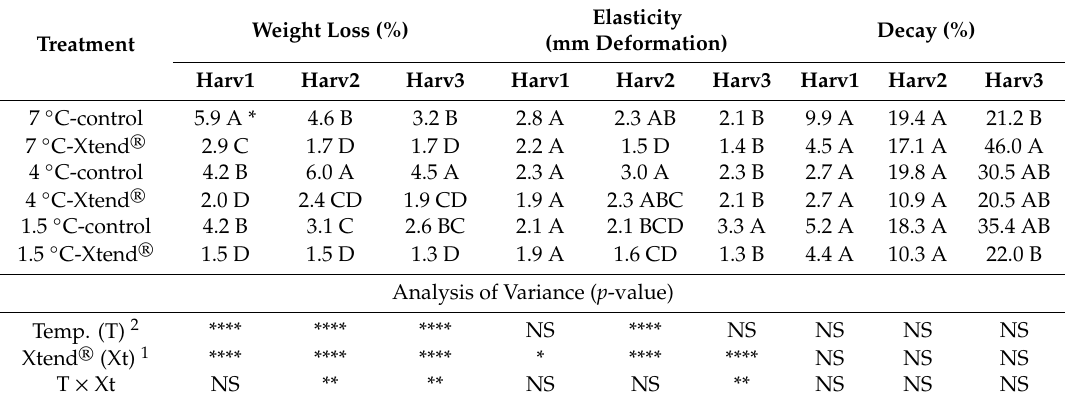
Table 1. The e ff ects of di ff erent temperatures and packaging (Xtend ® bag) on yellow pepper fruit, cv. Dinamo, in terms of weight loss (% of initial weight), elasticity (mm deformation) and decay (%) after 21 days of storage at di ff erent temperatures, followed by 3 days of storage at 21 ◦